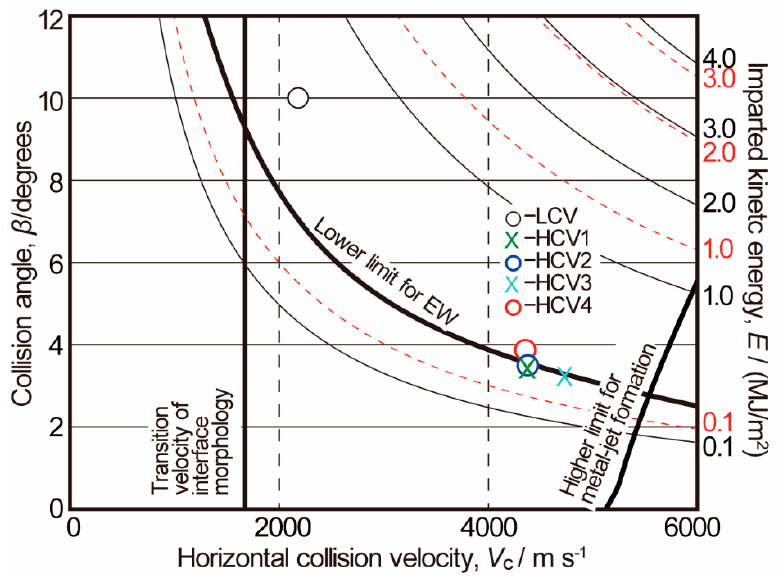
Figure 2. Relationship between estimated collision angles and horizontal collision velocities for LCV and HCV1–4 clads, together with contour curves of the estimated kinetic energies imparted to a flyer Mo using red broken curves for the HCV4 clad and black curves for the other clads.